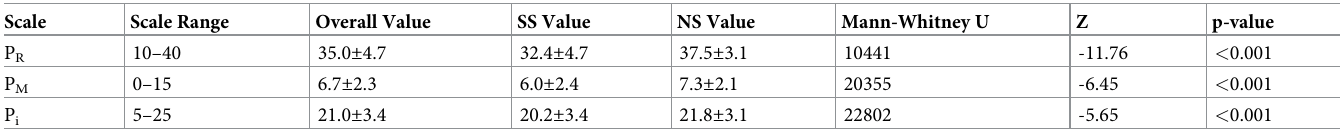
Table 4. Means of factor scores displaying standard deviation and Mann-Whitney U test showing the difference between SS and NS scale scores. Higher values indi- cate more favorable perceptions of respect (P R ), methodological rigor (P M ), or intelligence (P i ).